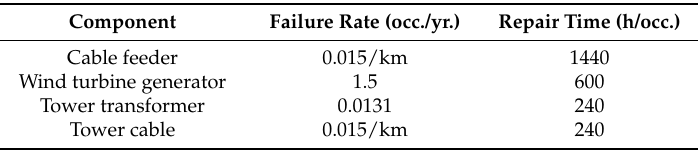
Table 4. Failure rate and repair time of wind farm equipment.